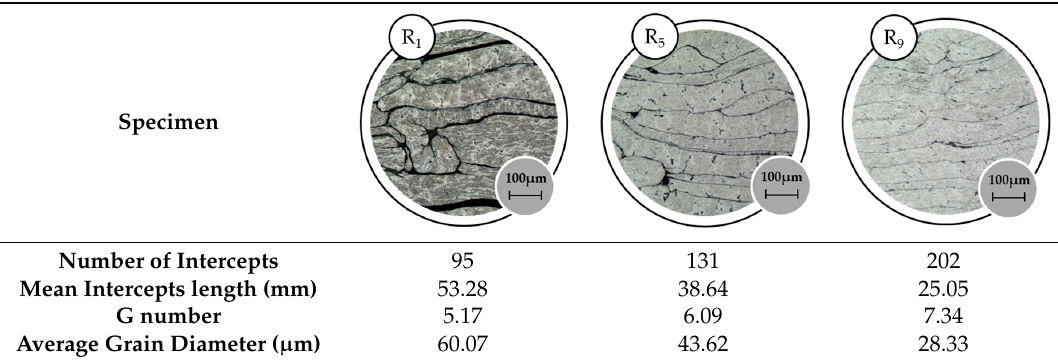
Table 5. Grain analysis on the effect of operating temperature and holding time.